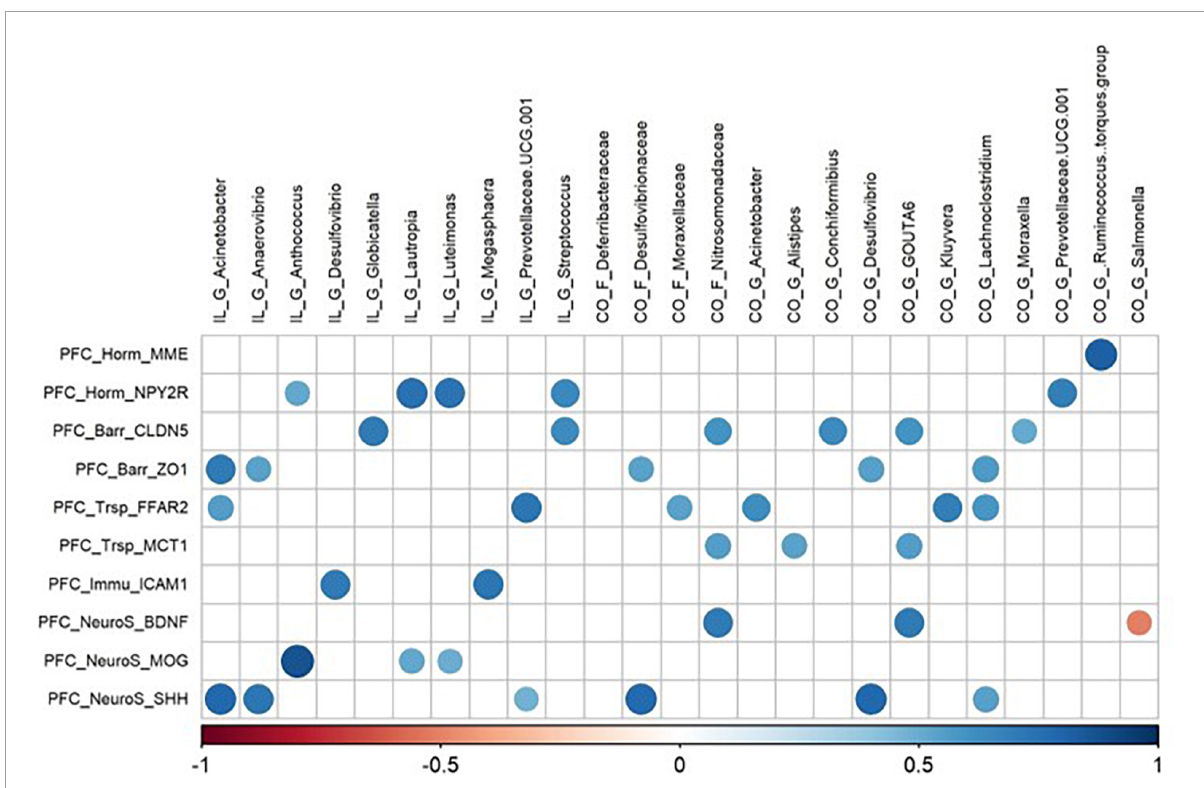
FIGURE8 Correlations matrix between prefrontal cortex relative gene expression and ileal and colonic microbiota (| r | ≥ 0.7, P < 0.05). IL, ileum; CO, colon; F, family; P, phylum; G, genera; PFC, prefrontal-cortex; Trp, tryptophan pathways; Horm, endocrine function; Barr, barrier function; Trsp, transport-nutrient carrier; Immu, immune function; NeuroT, neurotransmitters; NeuroS,